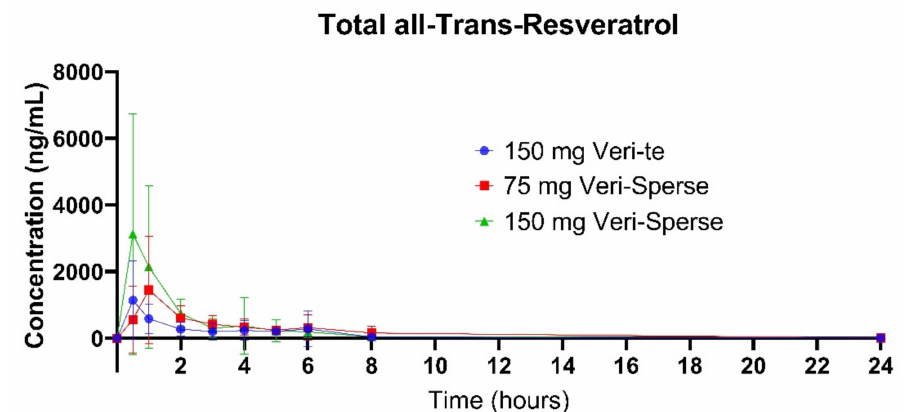
Figure 3. Plasma concentration for the sum of sulfate and glucuronide conjugates (all-trans-resveratrol) over 24 h after a single